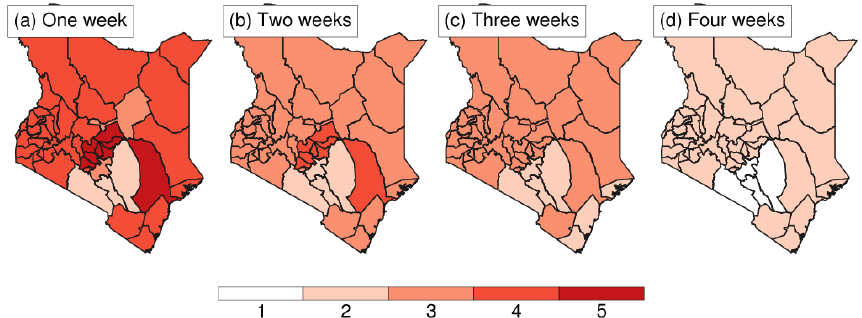
Figure 9. How many times per year might an FbF system based on advisories trigger? The number of potential triggers per county during 2019: here we assume that an action is triggered if an advisory is issued as long as no action had already been triggered in the preceding 1, 2, 3, or 4 weeks (a–d)